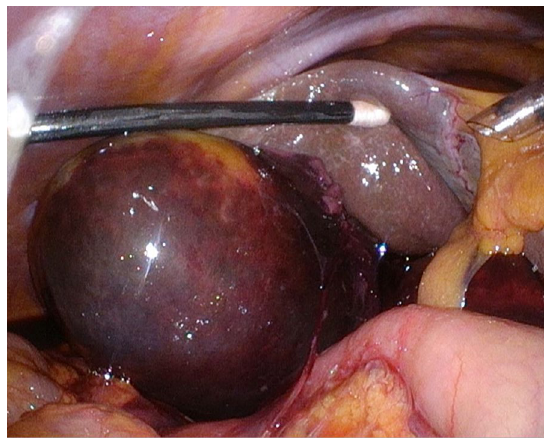
Fig. 2 An intraoperative photograph showing a tense gallbladder with a laceration of the serosa accompanied by hemorrhagic ascites